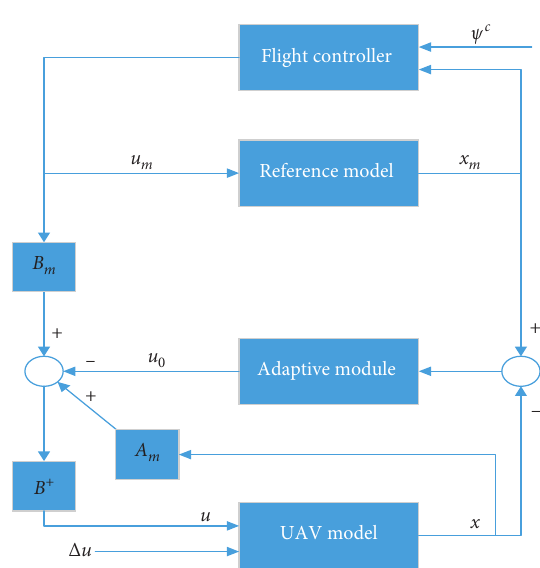
Figure 5: Model reference adaptive control for